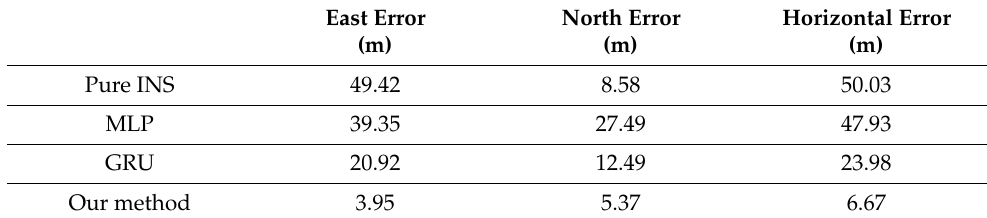
Table 3. Maximum position error of 180 s outage of Experiment 1.